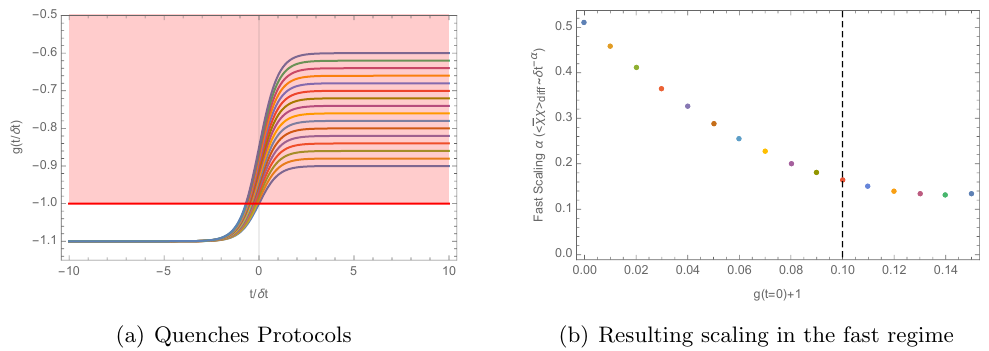
Figure 7 . Resulting scaling in the fast regime as a function of how deep inside the critical region it is measured. For the quench to the edge, it is expected a fast scaling of (cid:14)t (cid:0) 1 = 2 (see last subsection). That scaling slowly decays until it stabilizes when the distance inside the critical region is of the order of the initial amplitude (in this case, 0.1). At that stage (shown in dashed black line), the scaling of the expectation value becomes logarithmic, that in (cid:12)gure (b) is presented as a \small" power-law